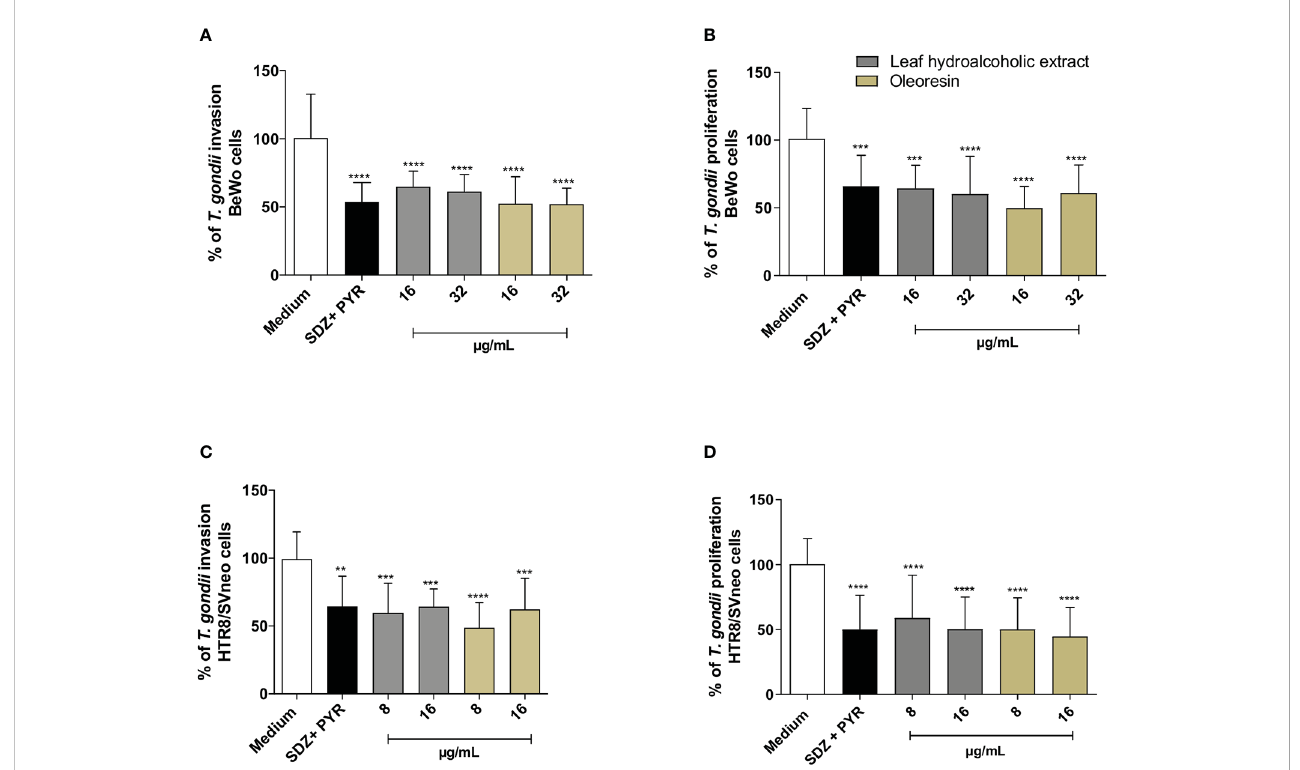
FIGURE 6 Invasion and proliferation assay. T. gondii tachyzoites were preincubated for 1 h with the hydroalcoholic extract or oleoresin from C. multijuga , and then allowed to interact with BeWo (A, B) or HTR8/SVneo (C, D) cells during 3 or 24 h to verify invasion and intracellular proliferation, respectively. As control, tachyzoites were incubated with SDZ + PYR or only medium (medium). The % of T. gondii invasion and the % of T. gondii proliferation were determined using the b -galactosidase activity. Untreated parasites (medium) were considered as 100% invasion and proliferation. The results were expressed as means ± standard deviation of three experiments performed in eight replicates. Signi fi cant differences detected by One-Way ANOVA and Bonferroni ’ s multiple comparisons post-test. ** P < 0.001, *** P < 0.0001 or **** P < 0.00001 in relation to the